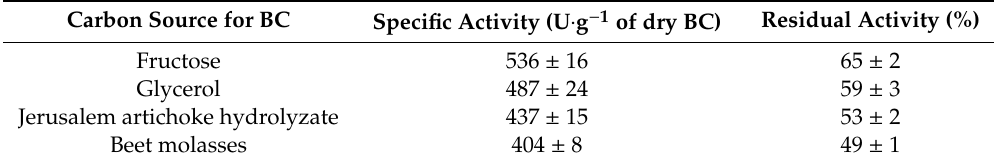
Table 3. Activity of His 6 -OPH immobilized into different BC samples.